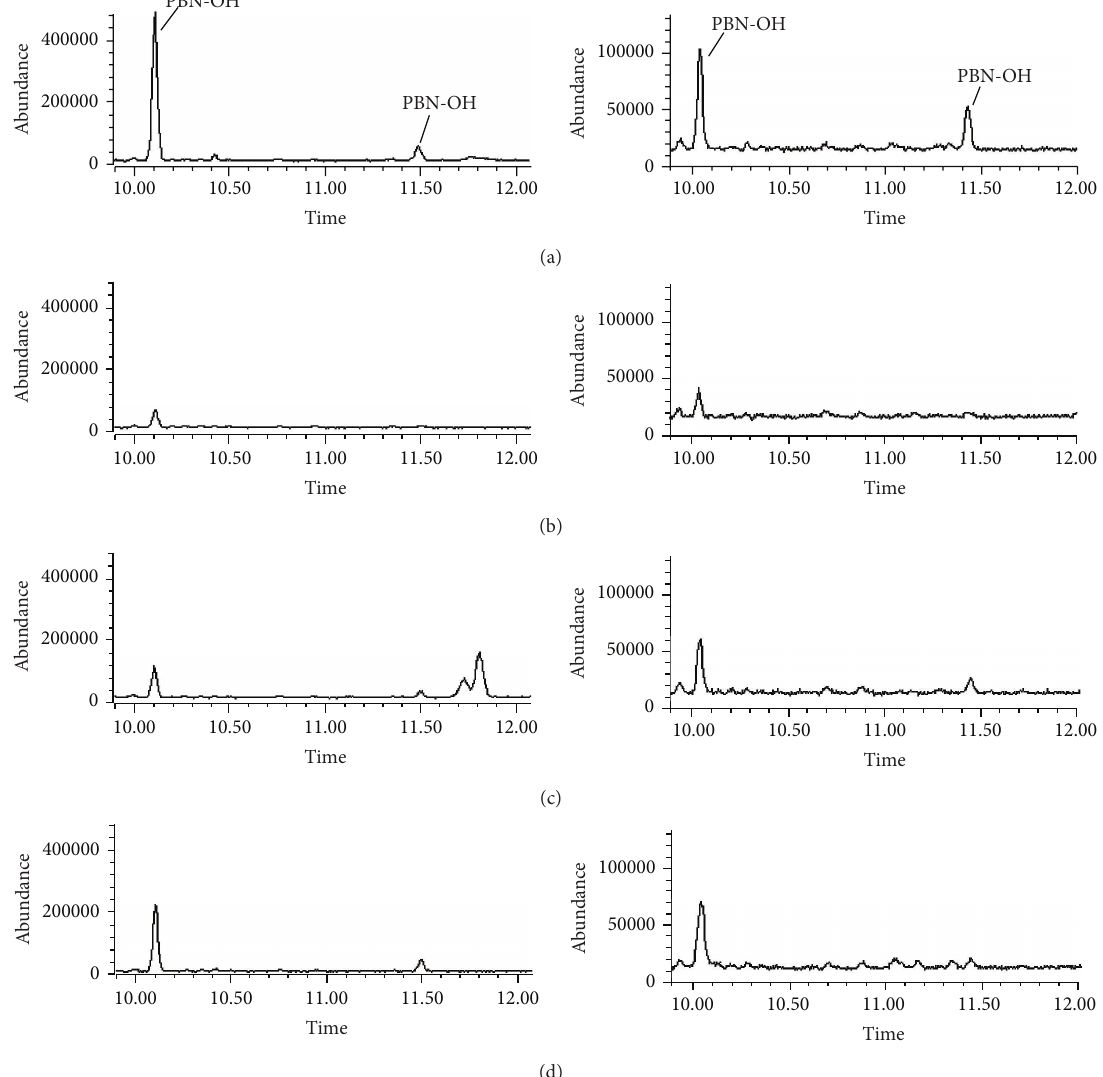
Figure 3: Selected-ion current profile obtained from GC-MS-SIM analysis of a sample from incubation containing cytosolic fraction and ethanol, in the presence of the spin trap PBN, after trimethylsilylation. Left: uterine horn cytosol. Right: liver cytosol. (a) Cytosol + hypoxanthine. (b) Cytosol + hypoxanthine + allopurinol. (c) Cytosol + hypoxanthine + ethanol. (d) Cytosol